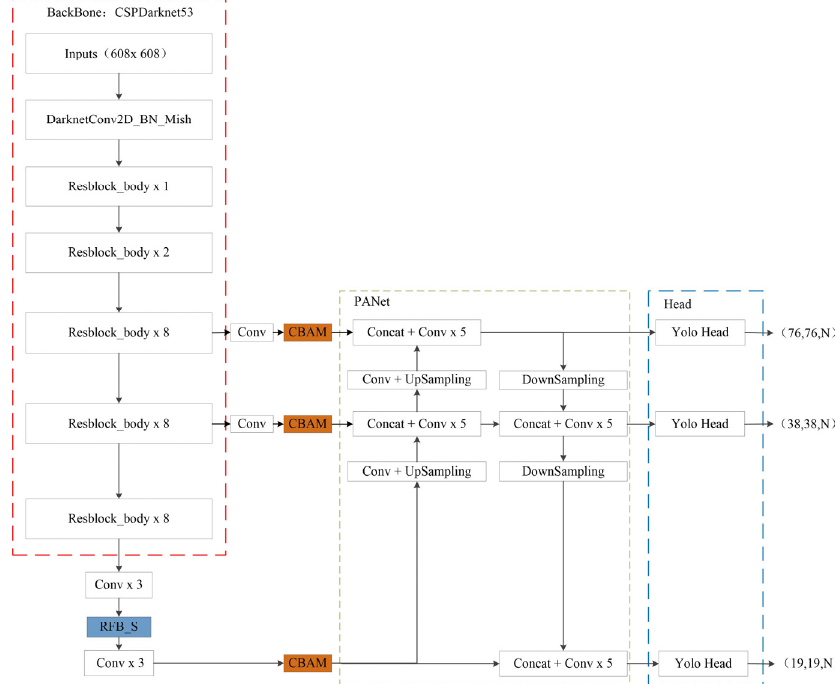
Figure 6. Our improved model structure